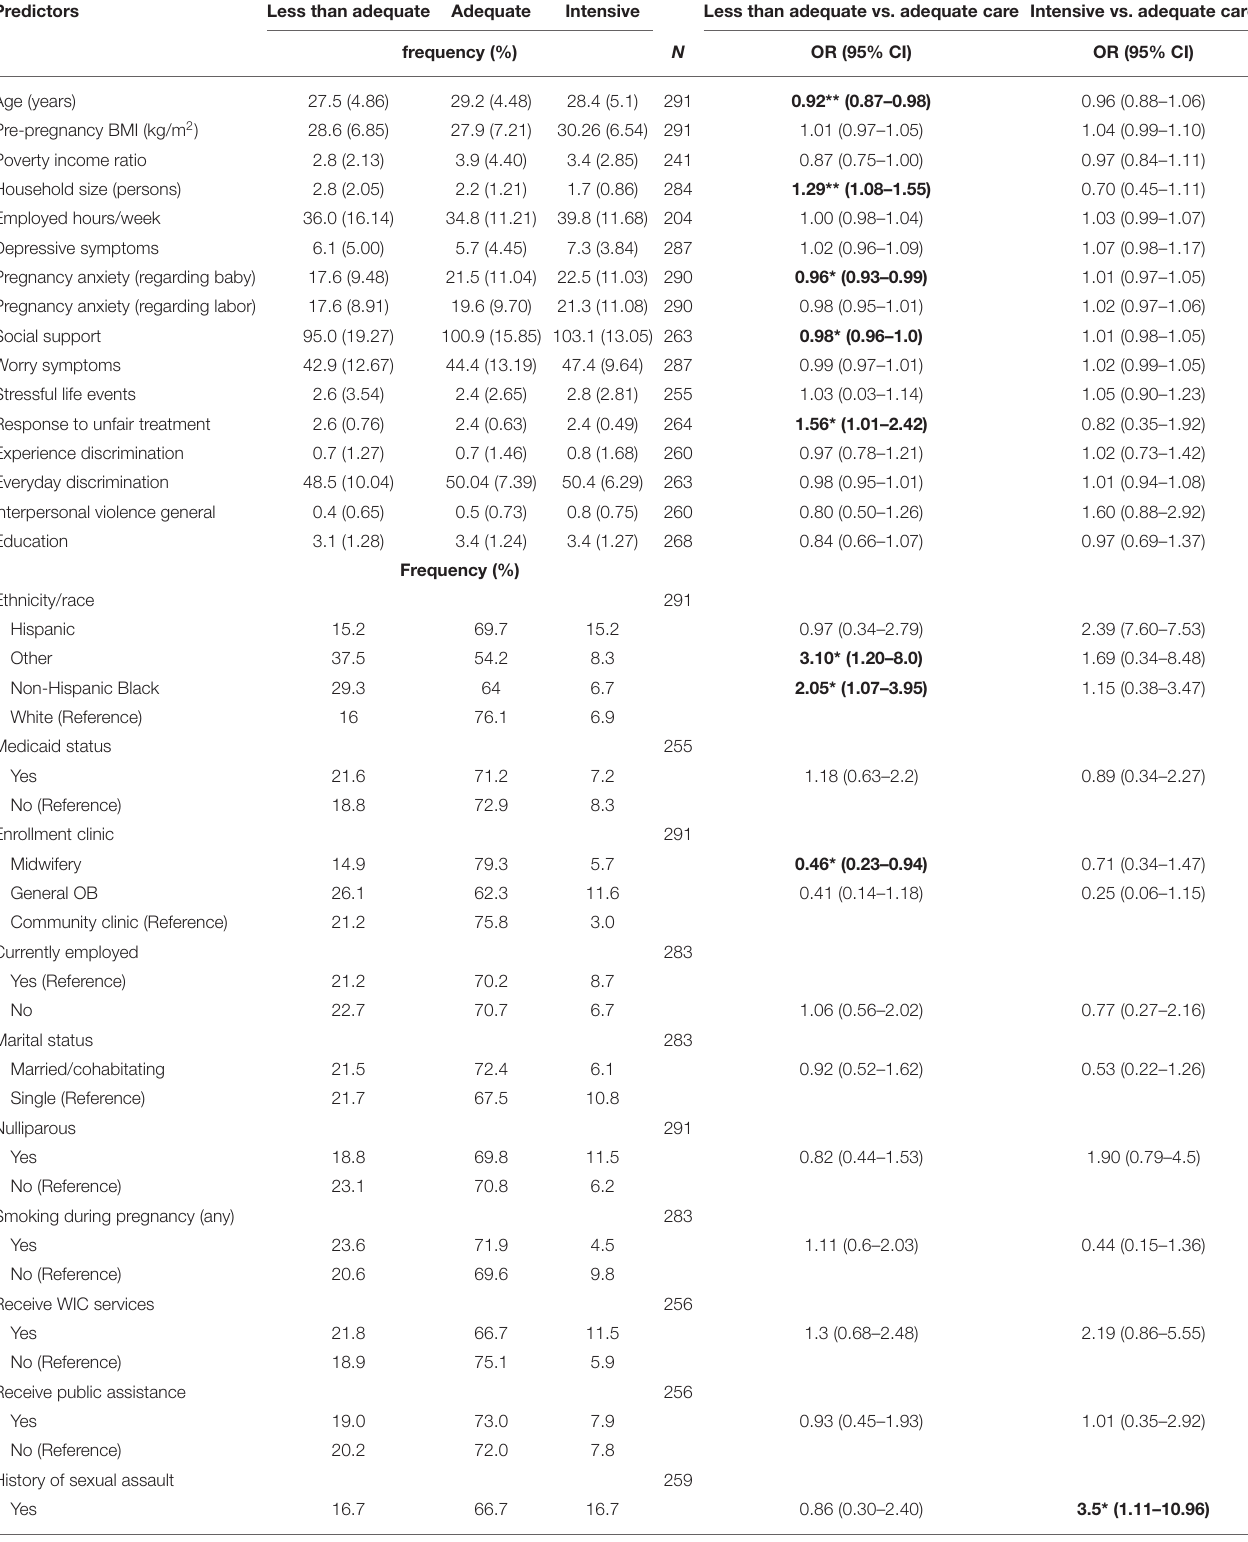
TABLE 2 | Bivariate logistic regression analysis predicting inadequate and intensive prenatal care vs. adequate prenatal care.